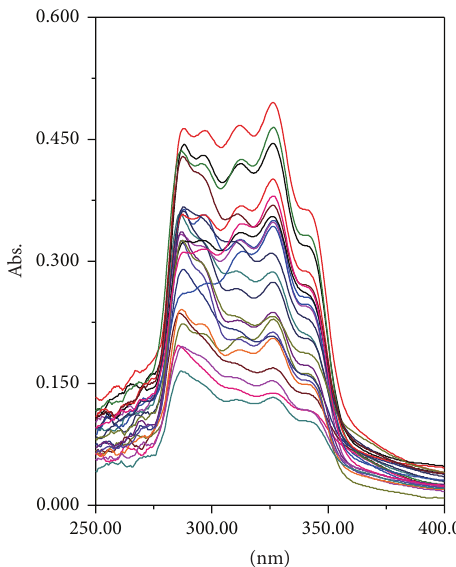
Figure 4: Two-dimensional spectra diagram of W. extensa scle- rotium